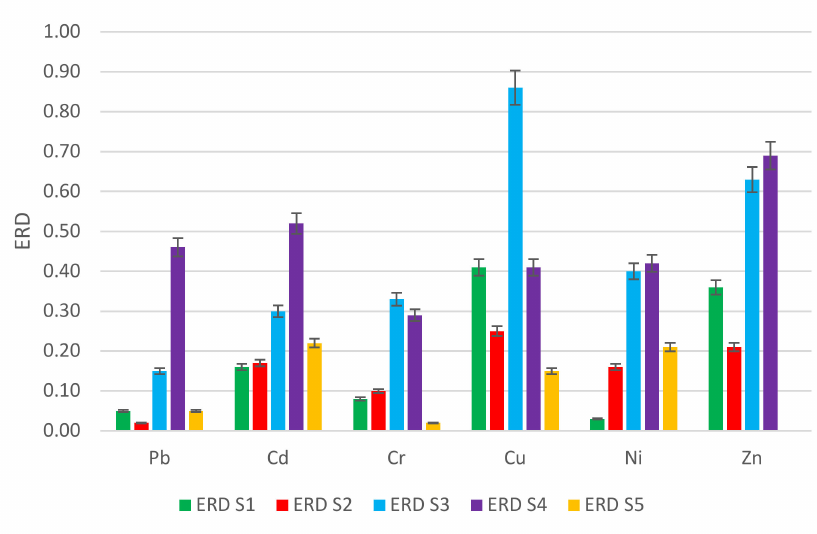
Figure 5. The environmental risk determinant (ERD) indicator of HMs in SS.